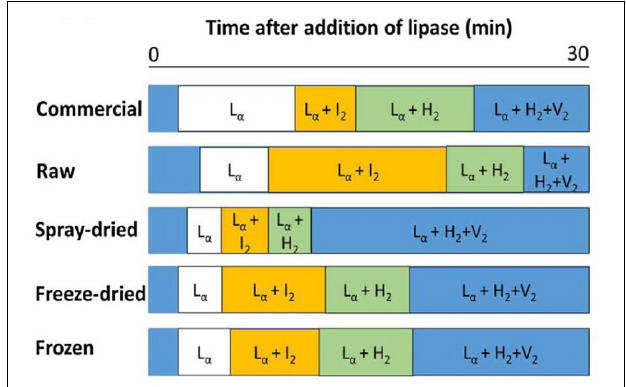
FIGURE 11 | The typical phase transition during the digestion of bovine milk subjected to homogenization and pasteurization (commercial), raw, spray-dried, freeze-dried, and frozen milk reported and reproduced with permission from Clulow et al. (2018). L α denotes lamellar phases formed by calcium soaps, I 2 denotes the micellar cubic (Fd3m) phase, H 2 denotes hexagonal phase, and V 2 is the bicontinuous cubic (Im3m)